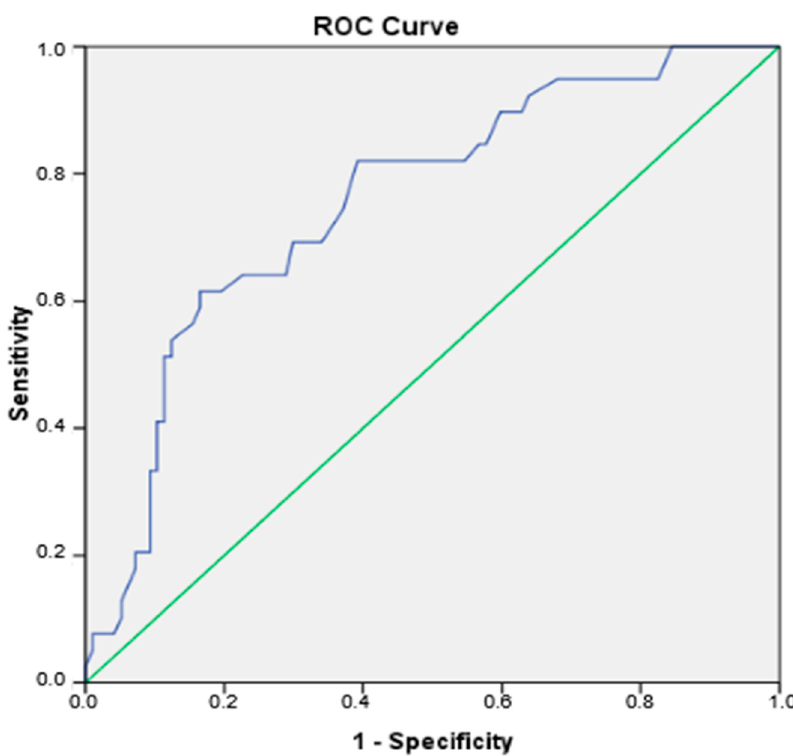
Figure 1. A ROC curve for AIP in the diagnosis of fatty liver